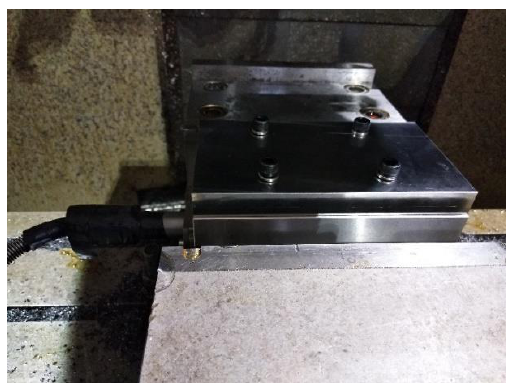
Figure 1. Photo of the dynamometer and the workpiece clamped in the workplace of machining enter.